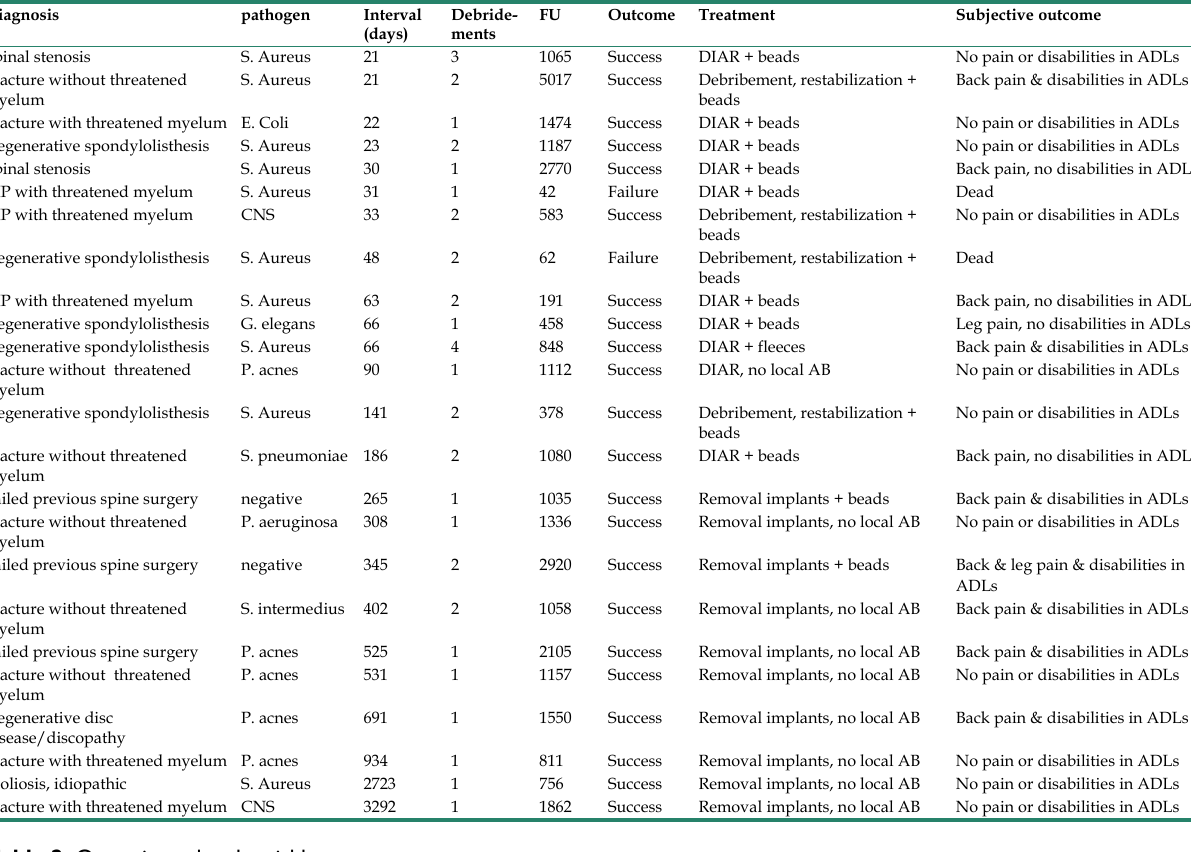
Table 2. Operation related